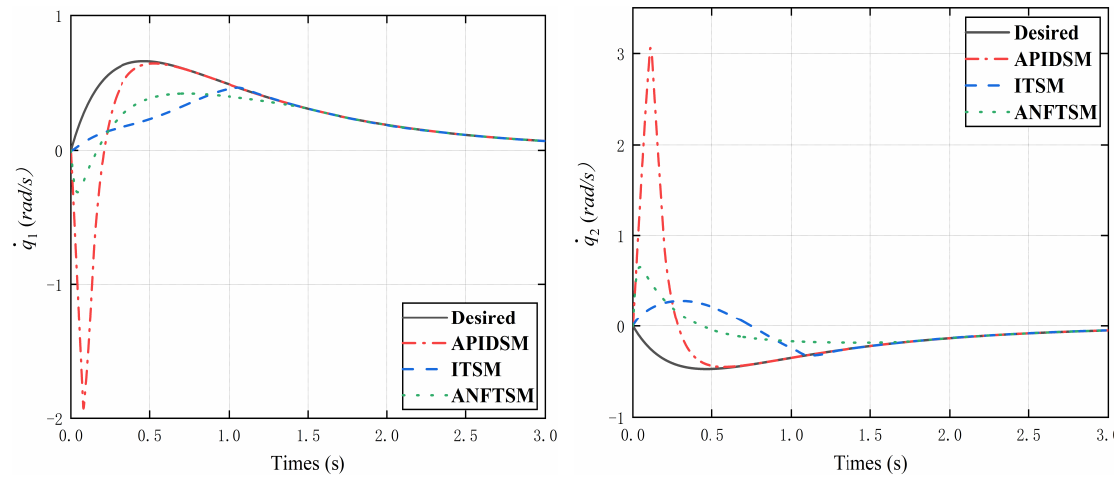
Figure 11. Comparison of velocity tracking results between controllers of Joint 1 and Joint 2.